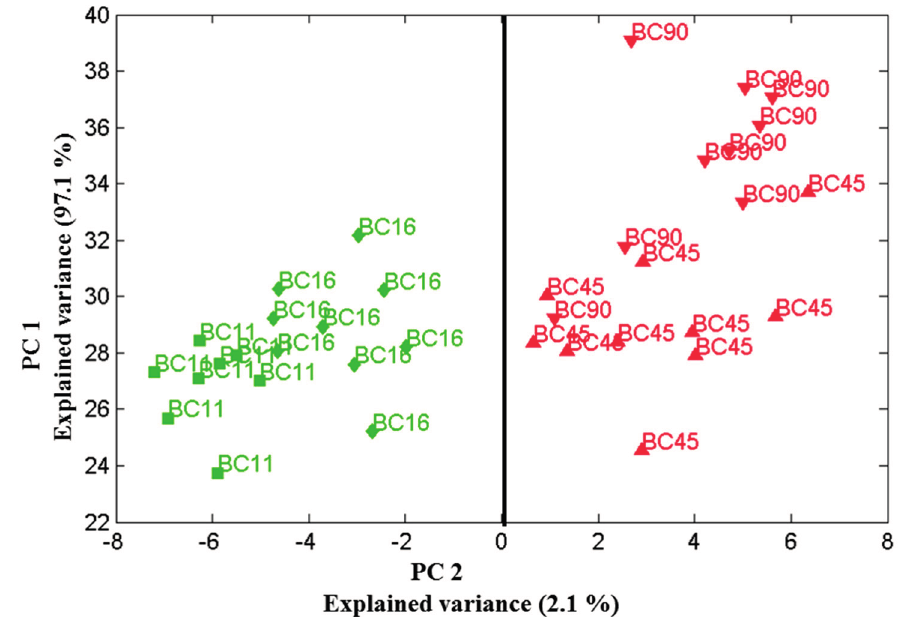
Figure 5. Scores plot of the first two principal components relation for four Candida parapsilosis strains (BC 11, BC 16, BC 45 and BC 90) cultured for 48 h. Using the two principle components, one can clearly separate the clusters of spectra associated with the biofilm-positive (BC 11, BC 16) and biofilm-negative (BC 45, BC 90) strains. Data sets were recorded on 19 December